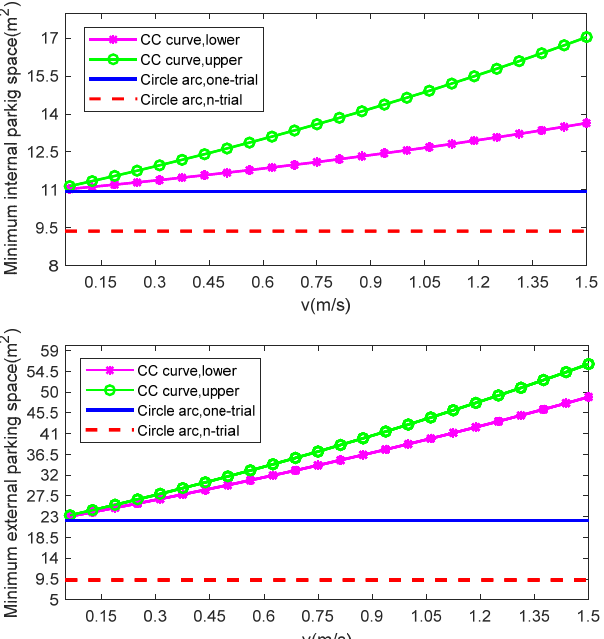
Figure 14. Comparison of the minimum internal and external parking space required by different parking methods.